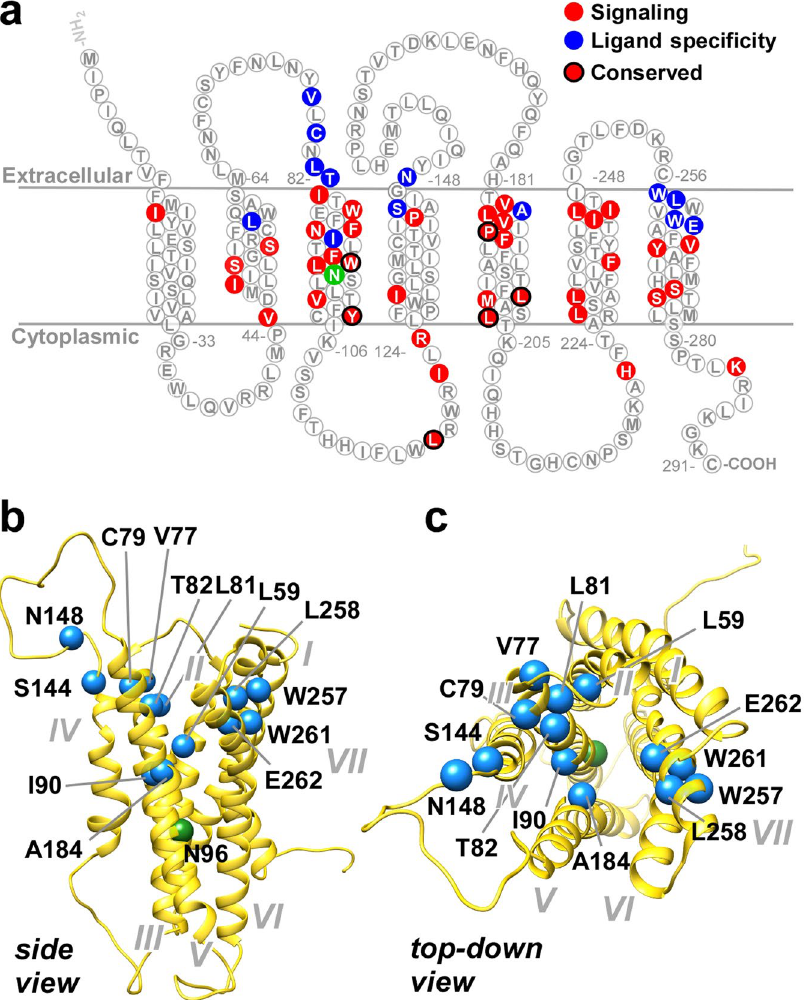
Figure 8. Summary of TAS2R16 residues critical for ligand binding and signaling. ( a ) TAS2R16 receptors with mutations at residues highlighted in blue signaled for at least one ligand, but failed to signal for another ligand. Residues highlighted in red failed to signal for all four ligands, but are expressed at wild-type levels on the cell surface. Signaling-critical residues that are highly conserved ( > 80% conservation among the 25 human TAS2R receptors) are circled in black. The N96 position which contributes to TAS2R16 probenecid sensitivity is shown in green. The residues implicated in ligand interactions (blue) are also shown on a TAS2R16 model structure (www.gpcrdb.org). The side view ( b ) suggests that the residues are located primarily in the membrane close to the extracellular side of the membrane, consistent with the locations identified in ( a ). TMs are identified by Roman numerals. The top-down view ( c ) suggests that the residues form a broad, two-sided ligand binding